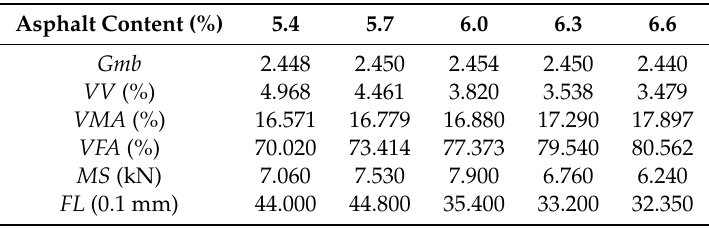
Table 3. Testing Data for Determining Optimum Asphalt Content (OAC)